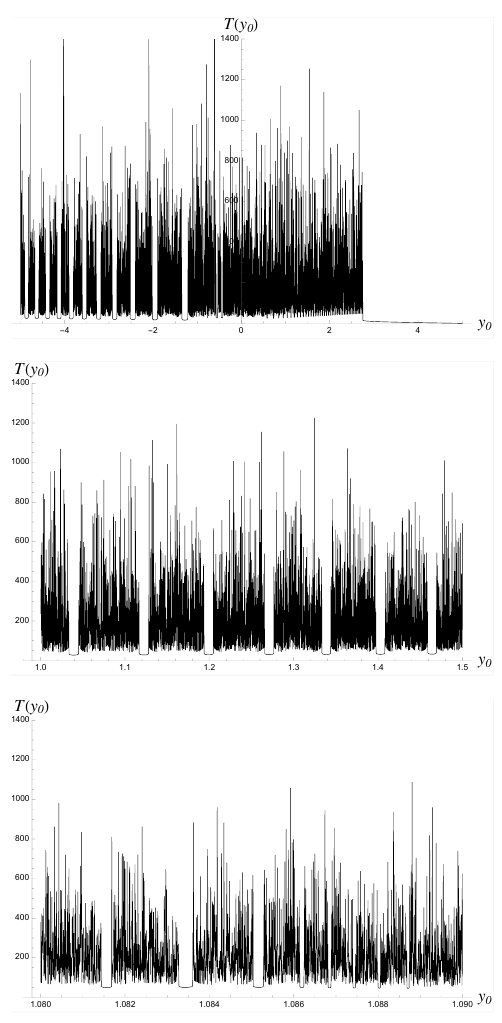
Figure 9 . Time delay function for x = 0 , p y = 0 . 3 , E = 0 . 1 . Here y 0 is an initial value of y . The second is a zoom-up of the range 1 . 0 < y 0 < 1 . 5 . The third is a zoom-up of the range 1 . 08 < y 0 < 1 . 09 .